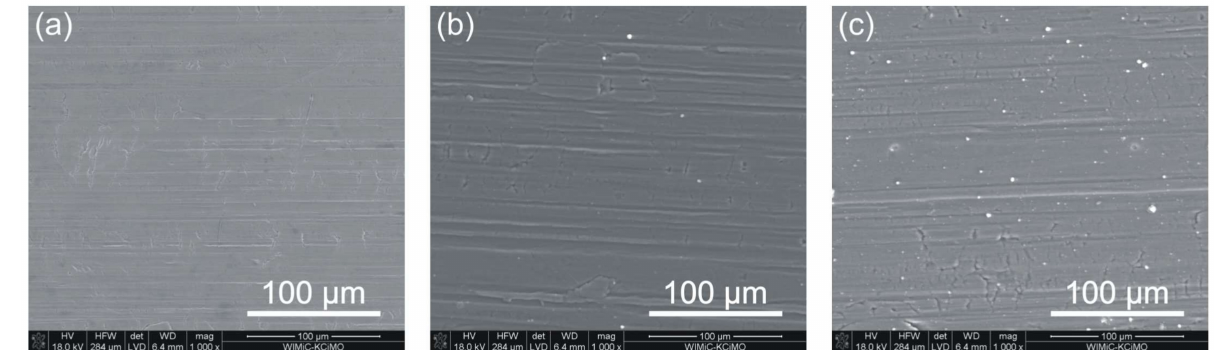
Figure 1. SEM images of the surface of the Crofer 22APU steel: ( a ) unmodified, ( b ) after SiC x N y :H